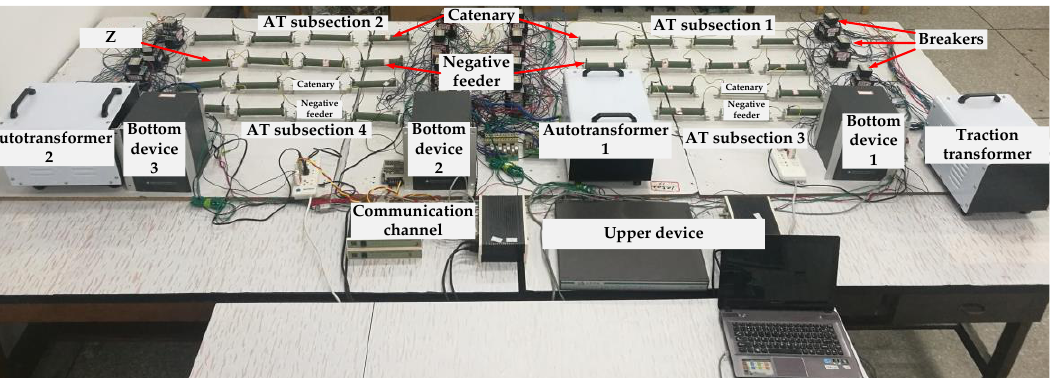
Figure 17. Equipment display of the experimental platform in the laboratory.